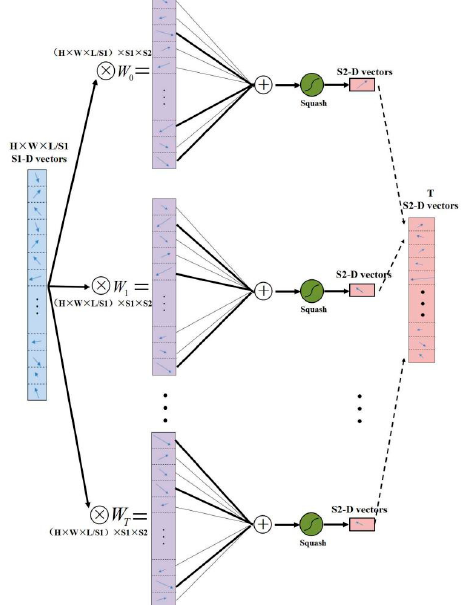
Figure 8. The detail of FinalCaps.